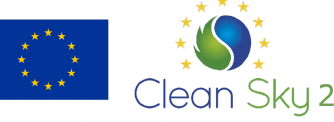
reduction screening design showing the standardized effect of each parameter and the combination of parameters (AB, AC, BC, ABC) on the resulting powder conductivity σ ; Figure S6: Fitted Raman results of thermal reduction samples reduced at increasing reduction temperature; Figure S7: IR spectra of thermally reduced graphene oxide powders after reduction at different temperatures T R